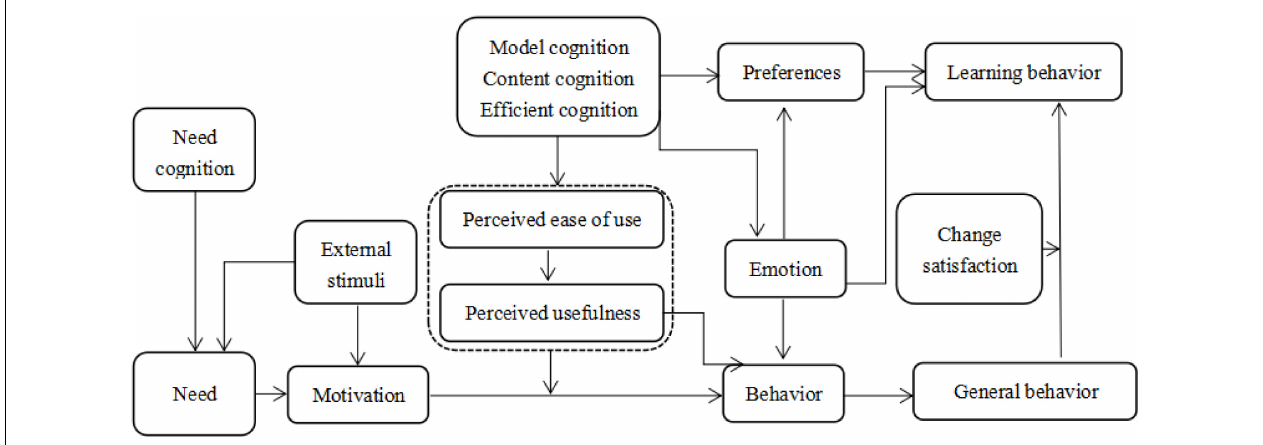
FIGURE 1 | The formation mechanism of learning behavior of those whose second language learning model is